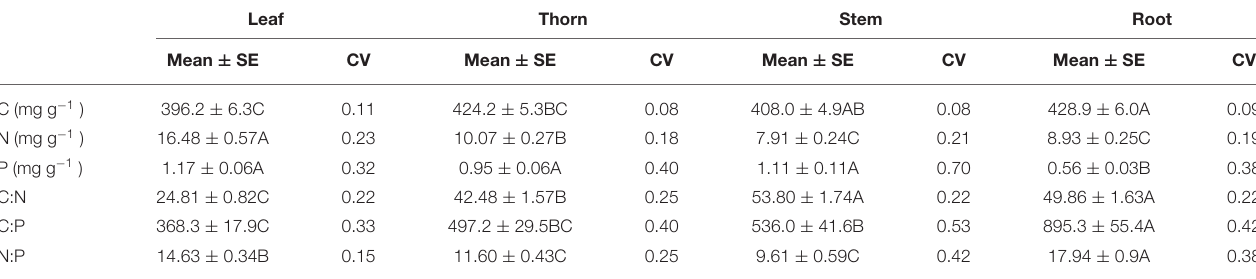
TABLE 1 | Carbon (C), nitrogen (N), and phosphorus (P) concentrations and the C:N, C:P, and N:P ratios in leaf, thorn, stem, and root organs of Alhagi sparsifolia . Leaf